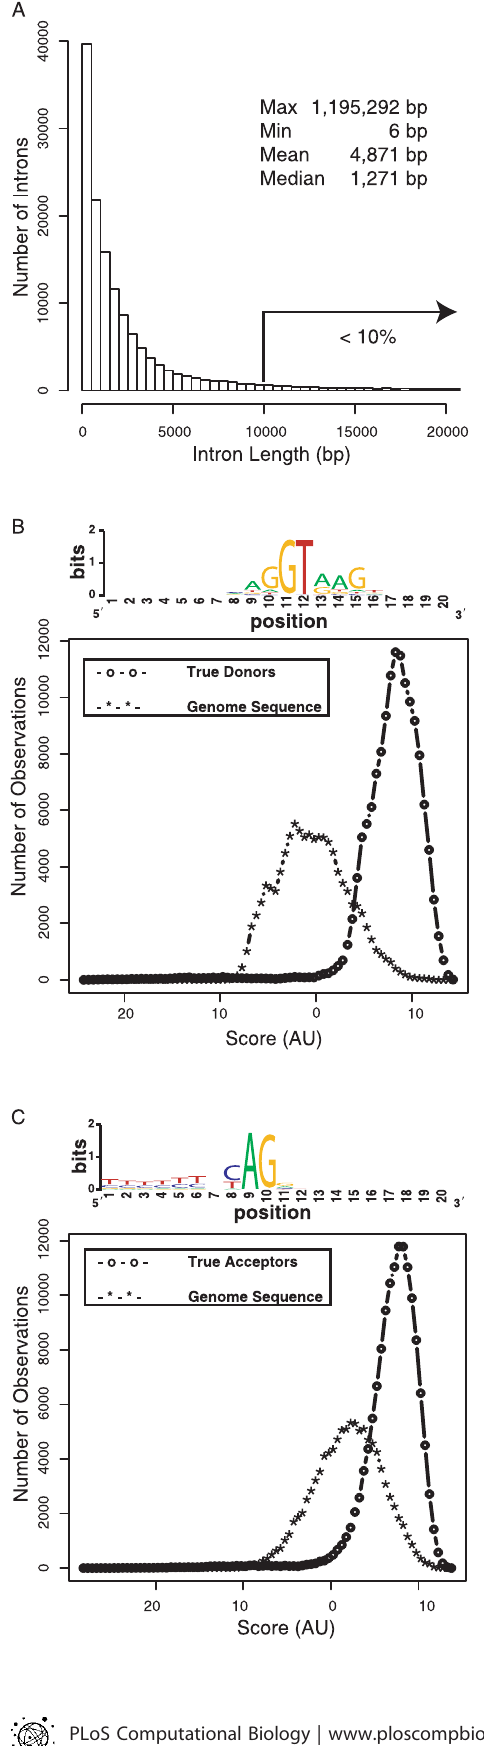
Figure 2. Length and Boundary Nucleotides of Introns Are Important Properties for Detecting a Splice Junction (A) Fewer than 10% of introns in RefGene annotation were greater than 10,000 bp in length. PWMs for splice junctions with respect to true donors (B) and true acceptors (C) were applied to true splice junctions defined by RefGene annotations and to randomly selected genome sequences containing the canonical dinucleotide pair at the appropriate position. The scores, which were computed based on the profile model, for donors and acceptors were plotted and showed that true splice junctions acquired high scores. The information content and the relative frequency of nucleotides at each position are measured in bits (vertical axis of the sequence logo diagrams) to indicate the strength of signals. Two bits of information are required to determine the content of a DNA